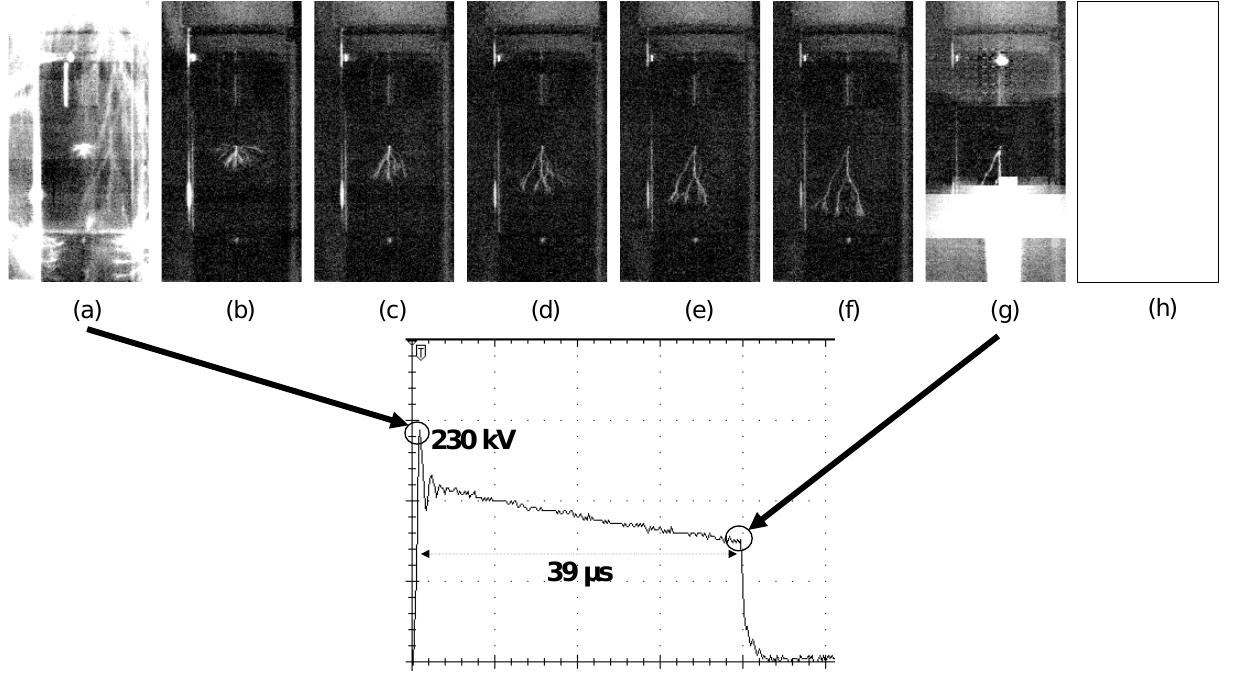
Figure 2. Images of 1% DEA in cyclohexane, positive polarity (230 kV peak, 70 mm gap). Frame rate of 180,000 FPS, 5.55 µs between frames, exposure time is 4.82 µs, TTB from waveform is 39 µs. From frame ( a – h ) the elapsed time is 38.85 µs.